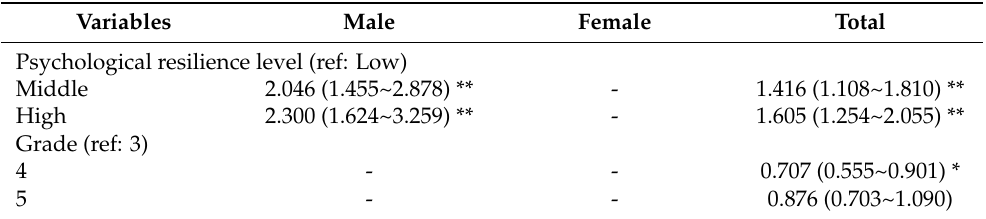
Table 3. Logistic regression analysis of factors influencing victims’ response to school bullying [ OR (95% CI